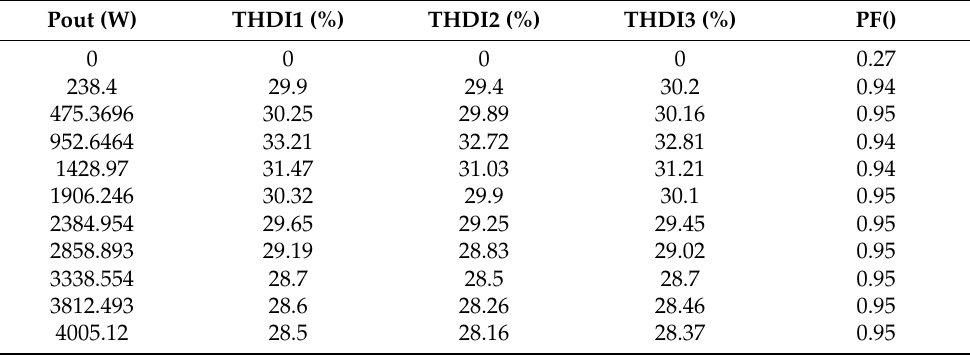
Table A1. THD and PF parameters for original transistor SiC IMW120R060M1H and alloy inductor (operating frequency 41